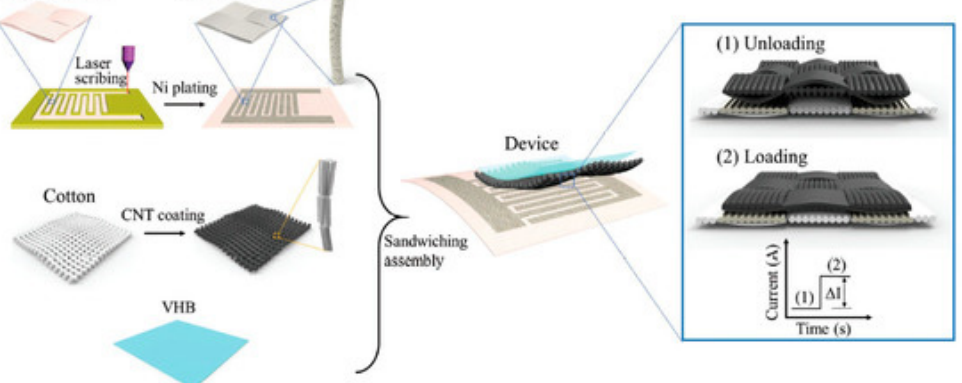
Figure 9. Detail example for the fabrication of textile pressure sensor based upon nickel (Ni) and carbon-nanotube-coated textiles. Figure reproduced from [99] under the terms and conditions of a Creative Commons CC-BY license agreement.